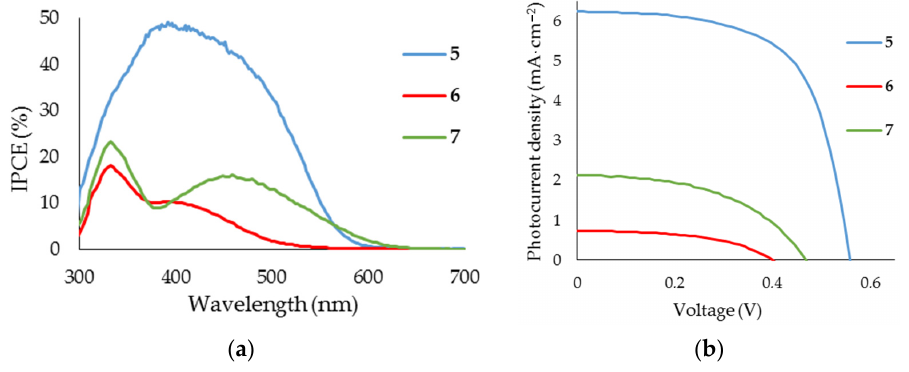
Figure 3. I-V curves ( a ) and IPCE ( b ) of the DSSCs prepared using dyes 5–7 . Figure 3. I–V curves ( a ) and IPCE ( b ) of the DSSCs prepared using dyes 5–7 . Table 3. Photovoltaic parameters of DSSCs sensitized with molecules 5–7